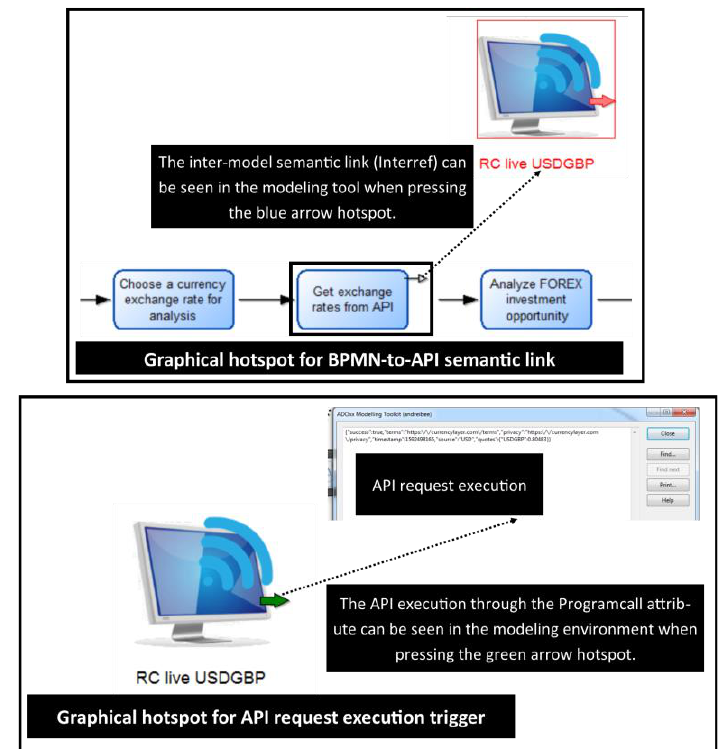
Figure 5. Visual cues acting as interactive